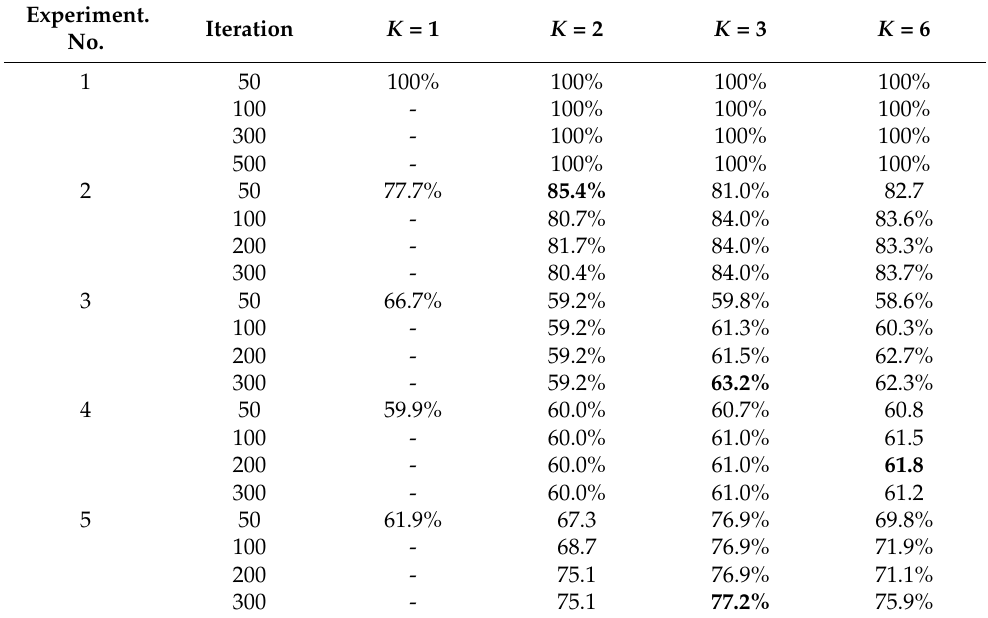
Table 3. Results of CCA with different number of (clusters, iterations).